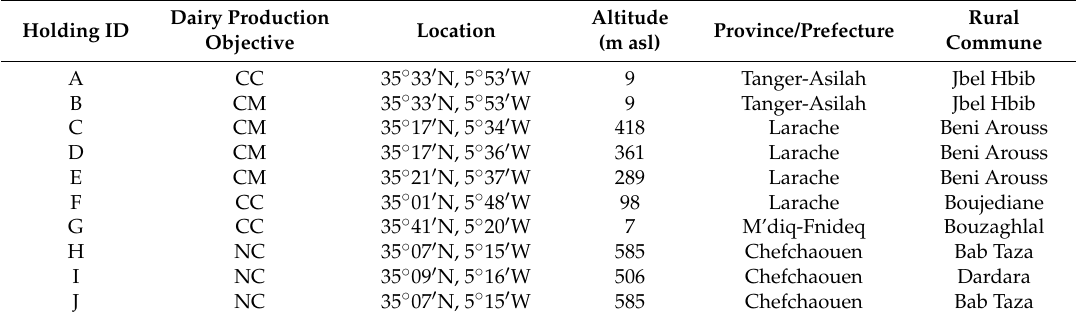
Table 1. The location and altitude of the goat holdings used in the study to assess the financial viability of intensification in northern Moroccan goat